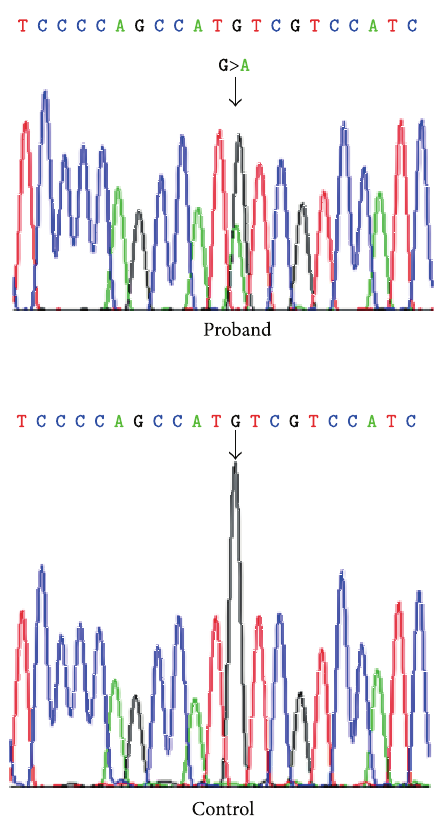
Figure 3: Sanger sequencing chromatogram revealing the pathogenic SMAD3 mutation, c.3G > A (p. Met1Ile) in the proband versus the normal sequence in a